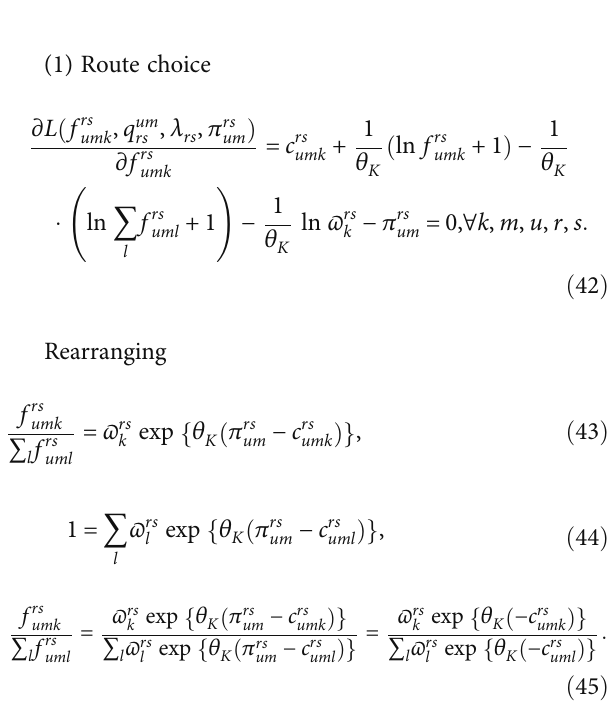
Algorithm 1: Solving the CMSTA